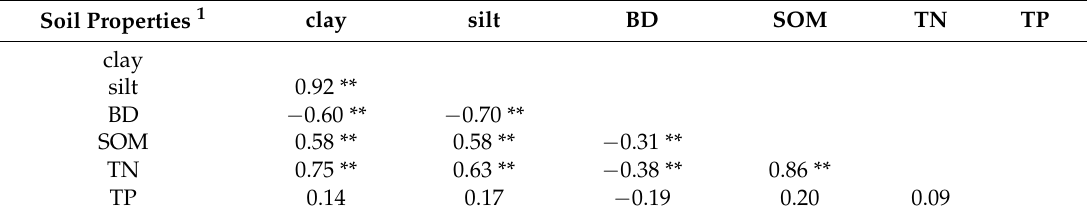
Table 2. Pearson correlation coefficients between soil